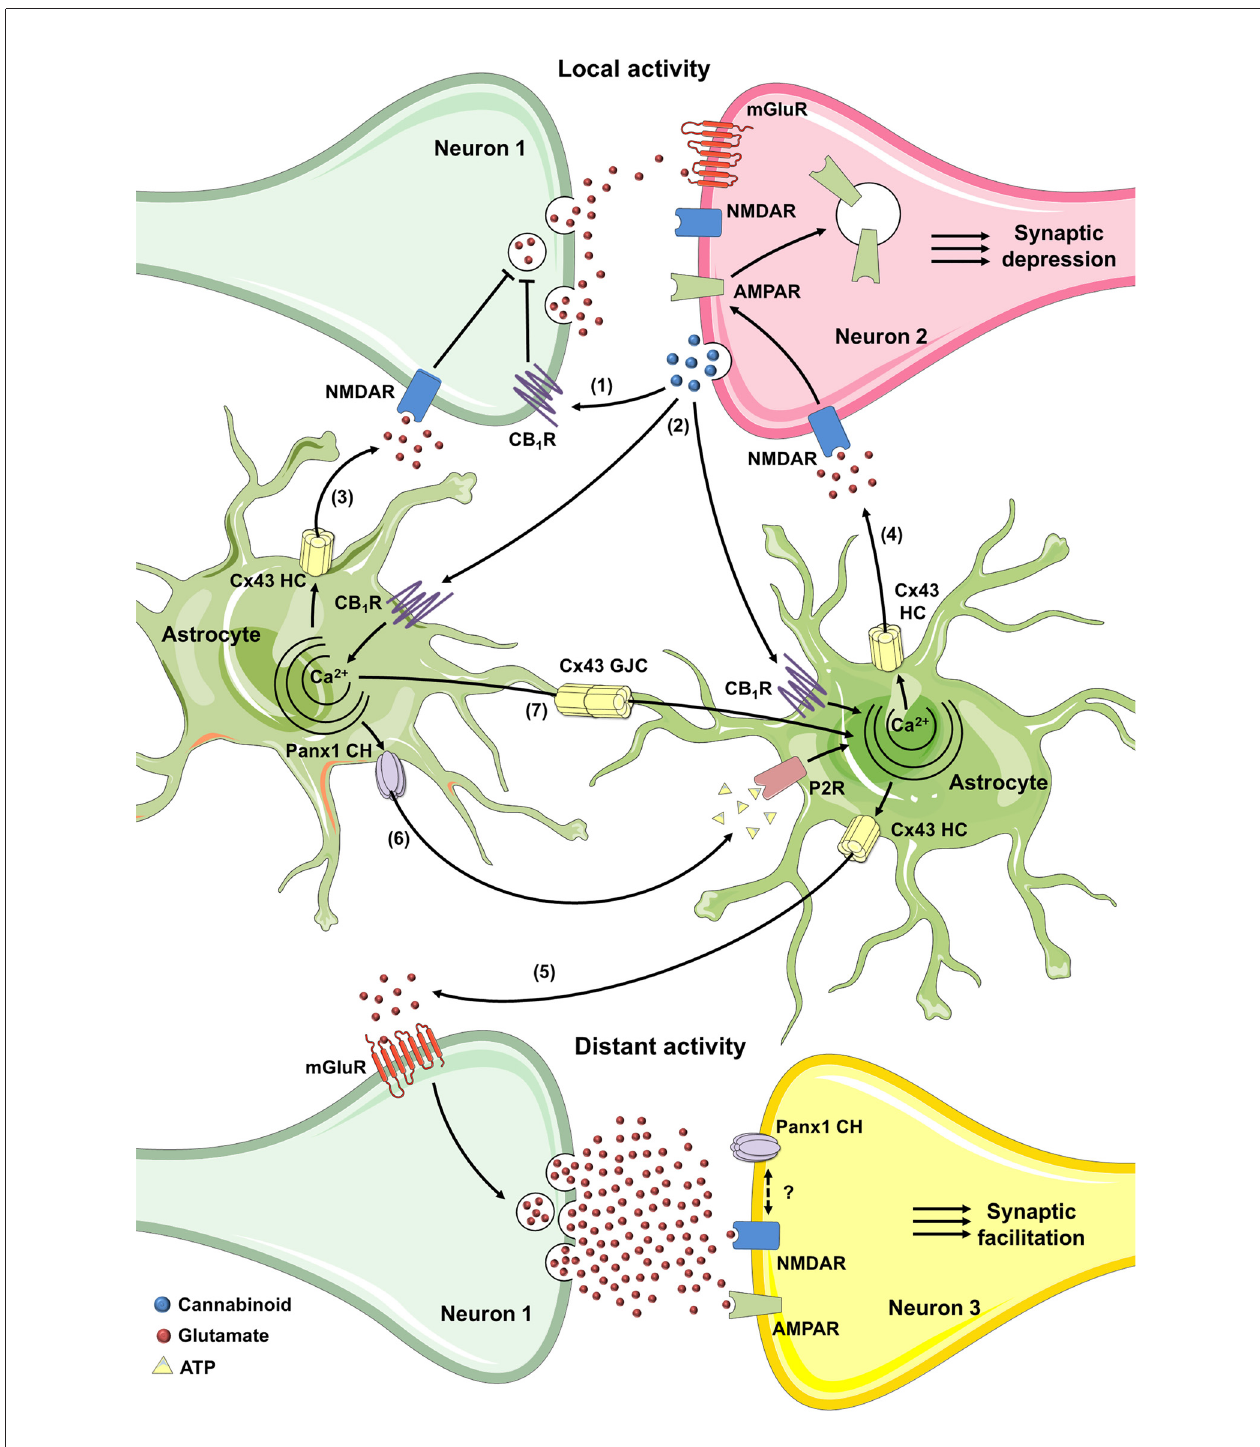
FIGURE 3 | Possible roles of connexin- and pannexin-based channels in CB-mediated synaptic plasticity through activation of astrocytes. In the hippocampus, the activity-dependent production of eCB triggers a decrease of neurotransmitter release through the stimulation of presynaptic CB 1 Rs in homoneuronal synapses (1). In the cortex and hippocampus, the coincidence of postsynaptic metabotropic glutamate receptor (mGluR) activation during synaptic activity and Ca 2 + influx (not depicted) caused by postsynaptic back-propagating action potentials evoke the release of eCBs (2). The latter stimulates astroglial CB 1 receptors and could elicit the Ca 2 + -dependent release of glutamate or D-serine through Cx43 hemichannels (3), leading to the activation of presynaptic NMDA receptors (NMDARs) and